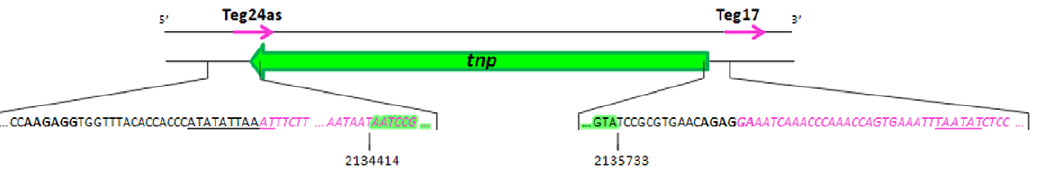
Figure 3. Schematic representation of antisense transcripts in the tnp region. Among the transposases annotated in the genome of S. aureus N315, antisense RNAs were identified 8 times at the extremities of the tnp transcripts, suggesting an important functional role. This example shows Teg24as and Teg17 (pink italic font) and their complementary tnp gene (green). In the sequences detailed below, the potential promoter sequences are underlined and the potential Shine-Dalgarno sequences appear in bold fonts.